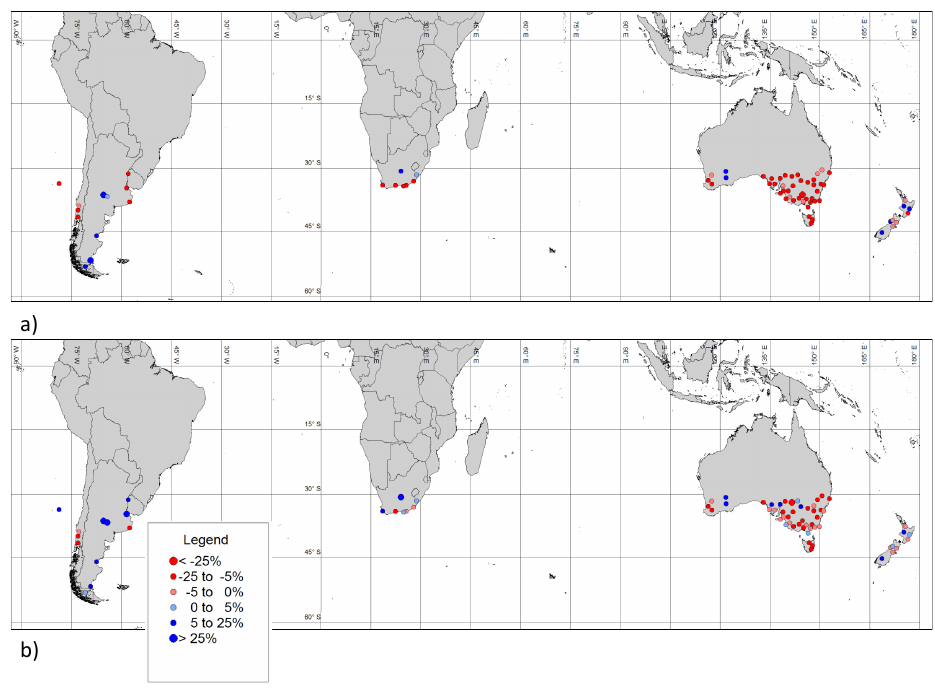
Figure 3. Difference in station-based rainfall (shown as a percentage change) for the period (a) 1994–2009 compared to 1948–1993, (b) 1976–1993 compared to